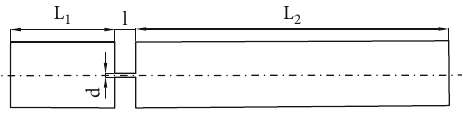
Figure 10: Geometric model of restrictor.